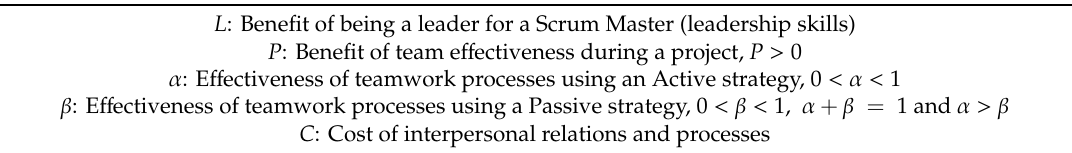
Table 4. Definition of the parameters